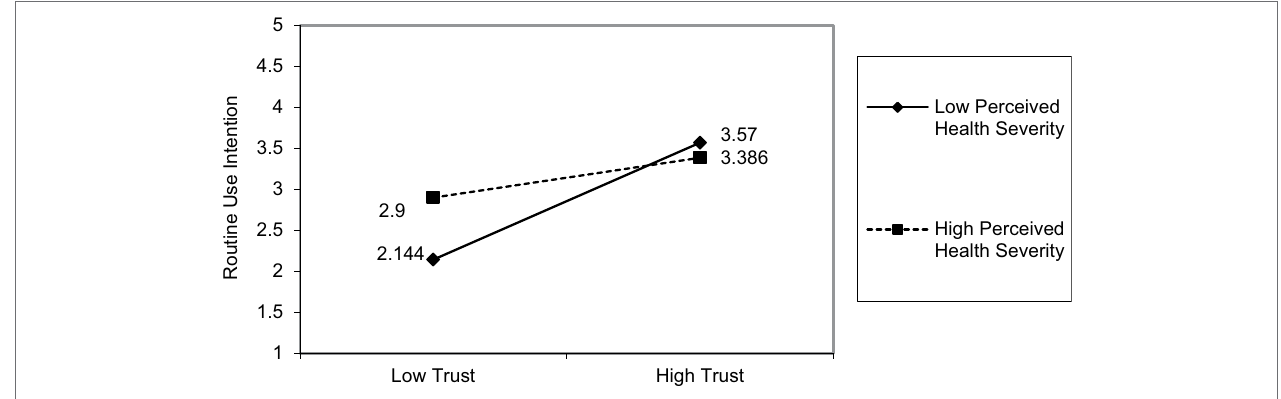
FIGURE 3 | Effects of perceived health severity on the relationship between trust and routine use intention.